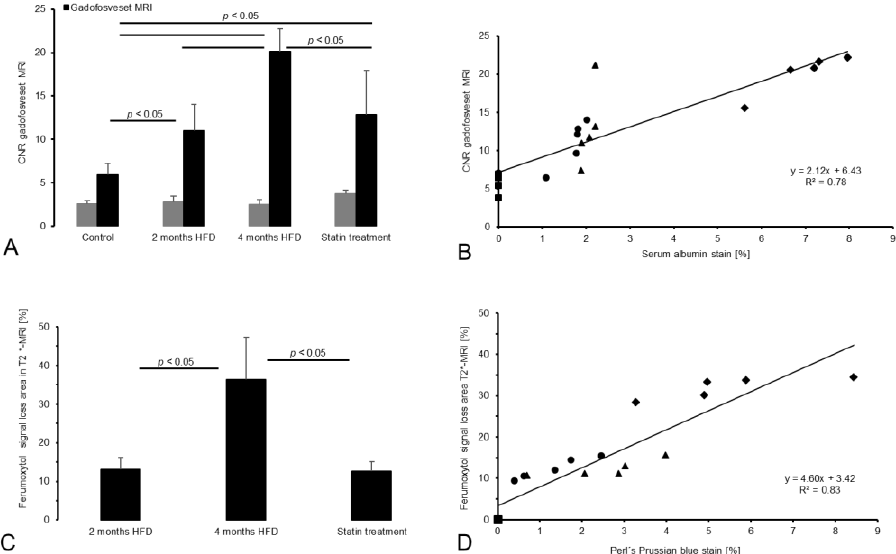
Figure 3. MRI findings following gadofosveset and ferumoxytol administration correlated with histology. ( A ) MRI of the atherosclerotic plaque area before and after administration of gadofosveset. In each group ( n = 5/group), the signal increased significantly between pre- and post-contrast images ( p < 0.05). Comparison between groups reveals an increase in CNR with disease progression ( p < 0.05). ( B ) The scatter plot data show a strong correlation ( p < 0.05) between CNR after gadofosveset administration and serum albumin staining [%] of the brachiocephalic tissue samples ( n = 5/group). ( C ) Ferumoxytol-induced signal extinction in the plaque area was most pronounced in the 4 months HFD group. No significant differences were observed between the 2 months HFD group and the statin treatment group ( n = 5/group). ( D ) The scatter plot demonstrates a significant correlation ( p < 0.05) between ferumoxytol-induced MRI signal loss and Perls’ Prussian blue stain [%] ( n = 5/group). Symbols: square — control group; triangle — statin treatment group; circle — 2 months HFD group; diamond — 4 months HFD group.